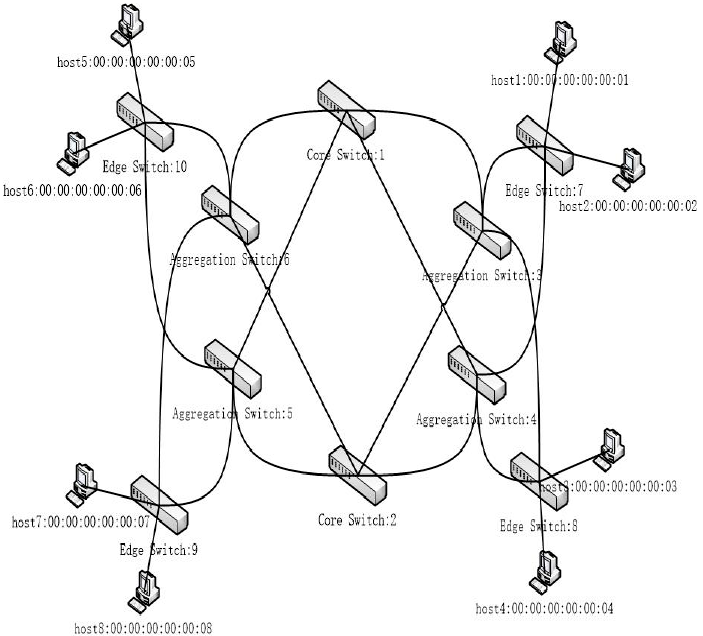
Figure 5. The target fat-tree topology.